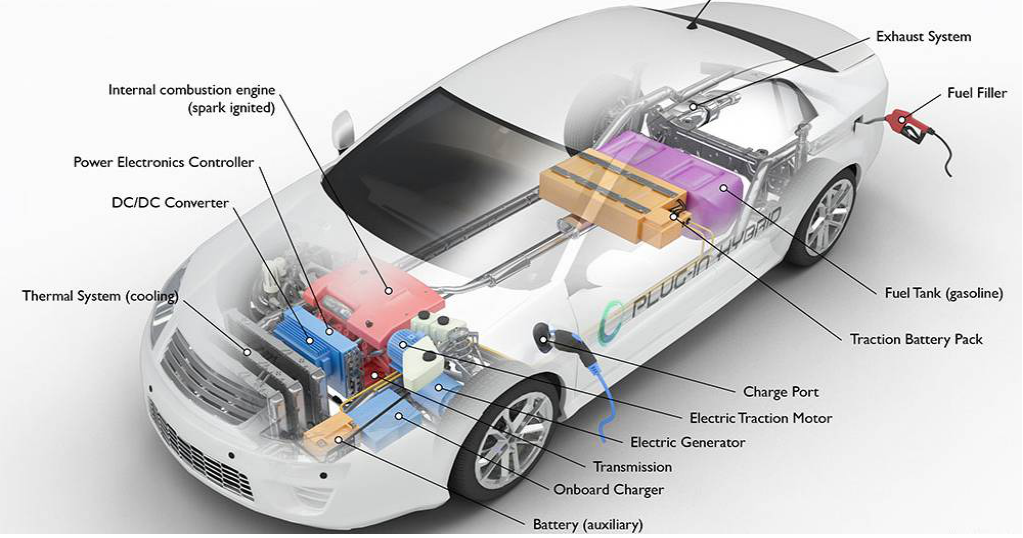
Figure 19. Diagram of a plug-in hybrid electric vehicle (PHEV) and its main components [108].